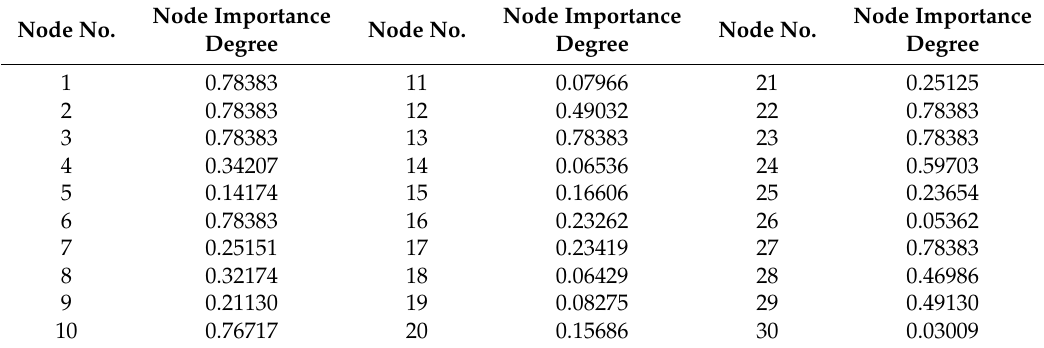
Table 5. Node importance degree of 30-bus microgrids.